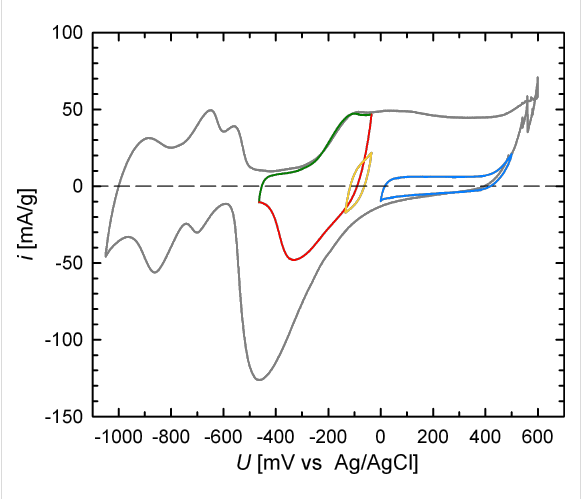
Figure 1: Steady-state cyclic voltammograms (CVs) of porous nanocrystalline Pt (sample Pt ER ) measured at a scan rate of v = 0.5 mV/s in different potential ranges from − 1050 mV to +600 mV (gray), − 465 mV to − 35 mV (green, red), − 135 mV to − 35 mV (yellow), 0 mV to +500 mV (blue) in 1 M